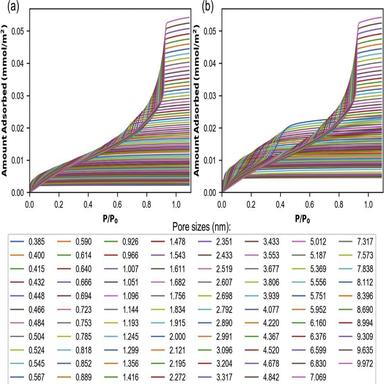
Simulated adsorption isotherm of CO2 in cylindrical carbon pore at 273 K highlighting the differences between equilibrium and adsorption branches. (A colour version of this figure can be viewed online.)